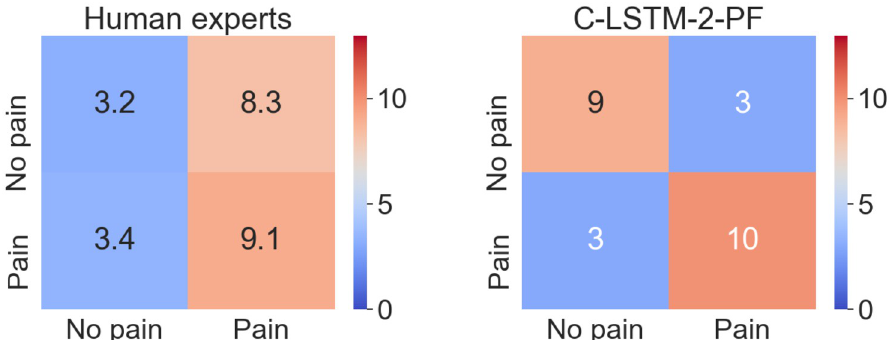
Fig 2. Pain predictions on the 25 clips included in the baseline study (Table 2), by the human experts ( left ), and by the C-LSTM-2-PF † ( right ).